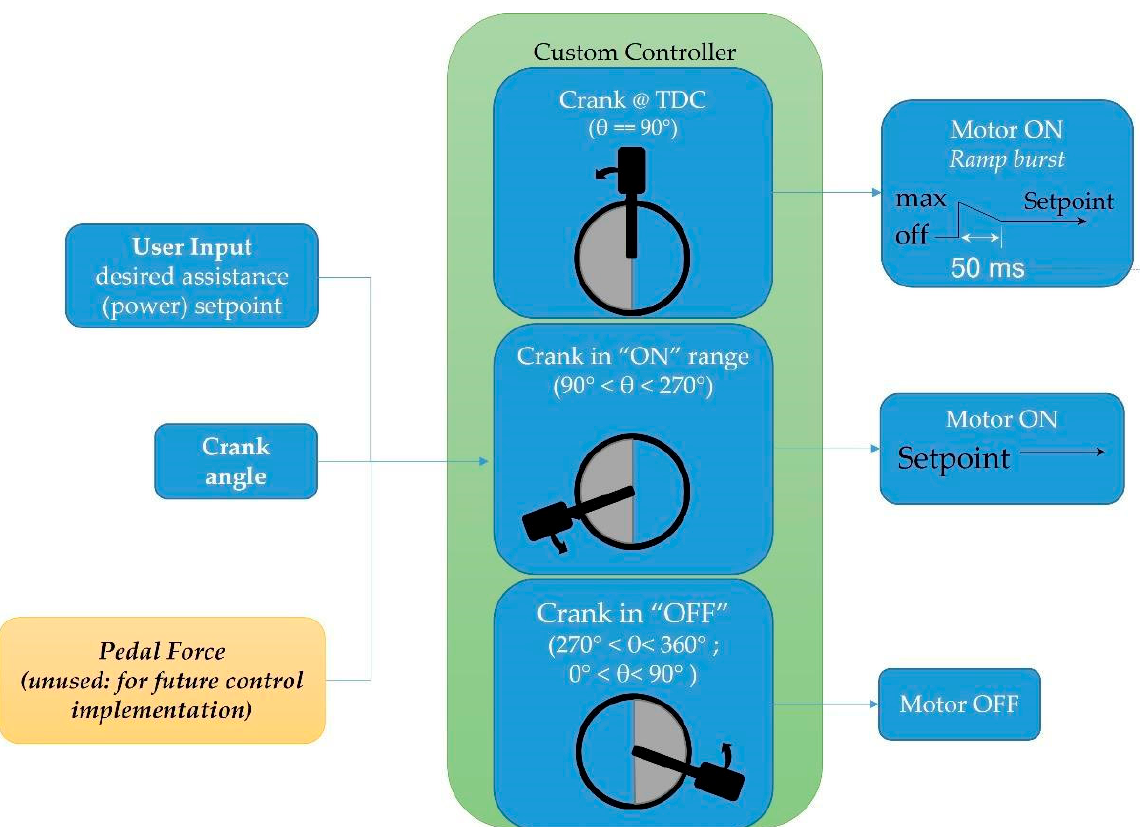
Figure 3. The custom motor control method implemented in the APAD provided assistive torque to the target leg.